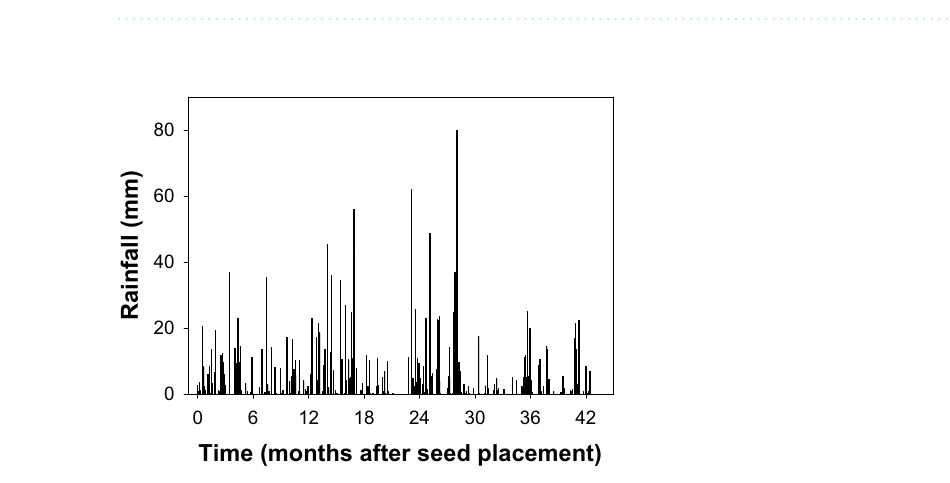
Table 1. Geographic locations and cropping history of weed seed collection.